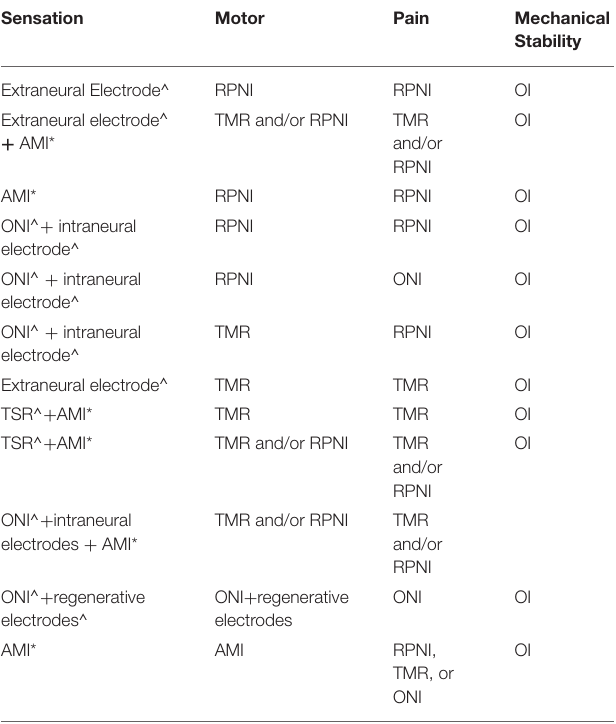
TABLE 3 | Potential Combination of different PNI’s.